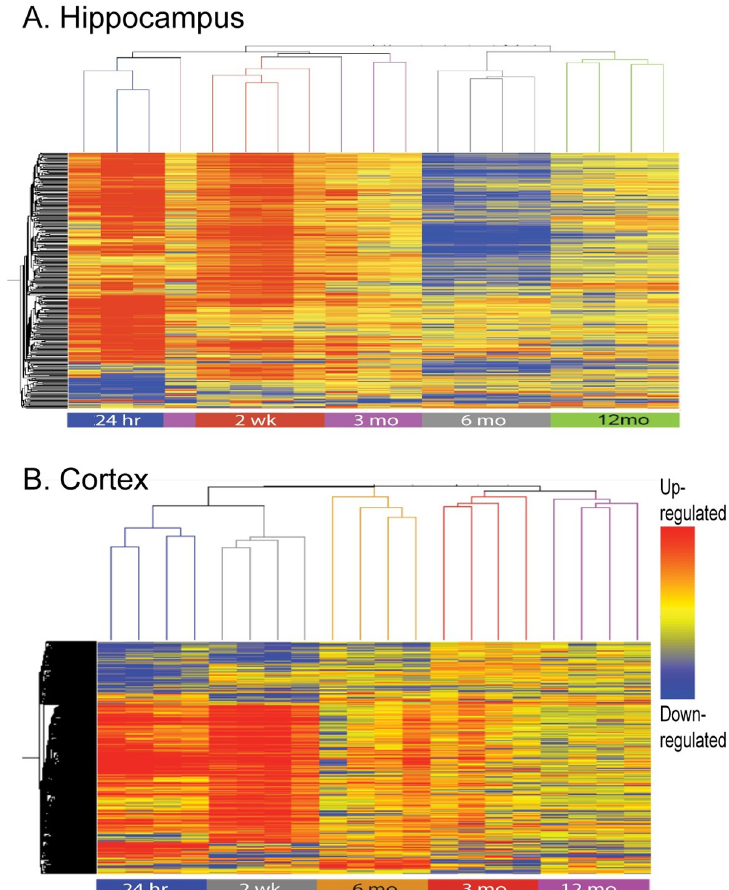
Fig 2. Hierarchical clustering of acute, subchronic and chronic gene expression after traumatic brain injury. Heatmaps of temporal (24 hour, 2 week, 3, 6,12 months) gene expression profiles of rat hippocampus (A) and cortex (B) after fluid percussion injury reflect the post-injury